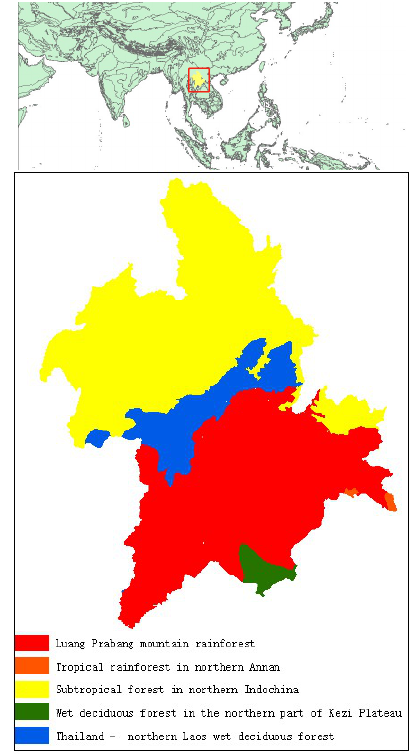
Fig. 3 (a) Location of the experimental area in the global geo- eco zoning and (b) geo-eco zones in the experimental area The experimental area includes five ecological zones, namely, Luang Prabang mountain rainforest(IM0121), Tropical rainforest in northern Annan(IM0136), Subtropical forest in northern Indochina(IM0137), Wet deciduous forest in the northern part of Kezi Plateau(IM0138),and Thailand - northern Laos wet deciduous forest(IM0139), as shown in Fig. 3(b). The land cover products in 2000 and 2010 are shown in Figs. 4(a) and 4(b). The number of pixels and proportion of each category in 2000 and 2010 are shown in Table 5 and